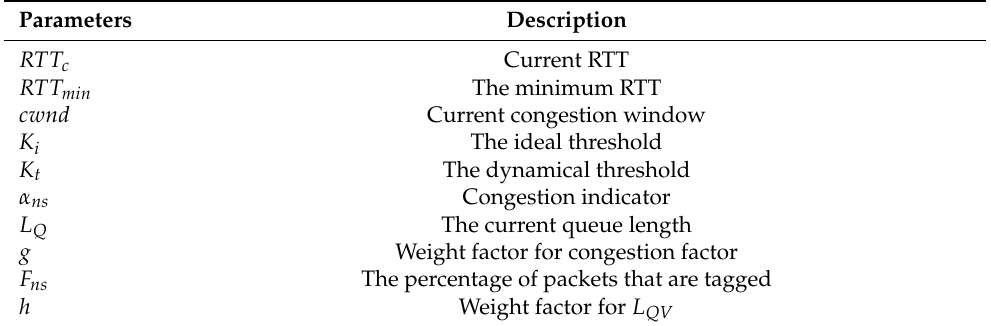
Table 1. Parameters and